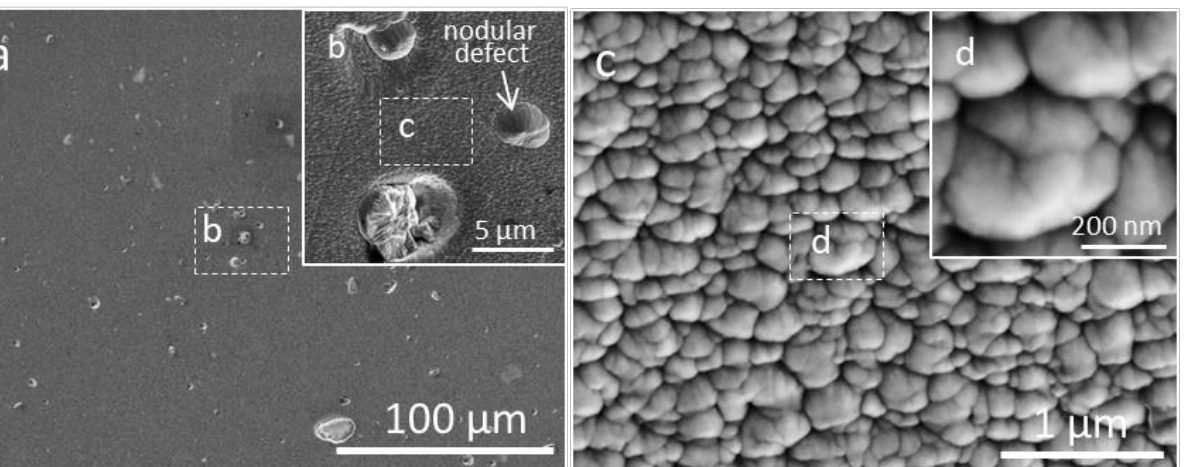
Figure 19. TEM cross-sectional image of a-CN/TiAlN and fracture cross-section SEM image of a TiAlCrSiN hard coating show how columnar microstructure changes the surface topography. It is evident that the surface roughness of the coating has its origin in the columnar microstructure. Both coatings were sputter deposited in the CC7 deposition system on tool steel substrates (ASP30, D2).